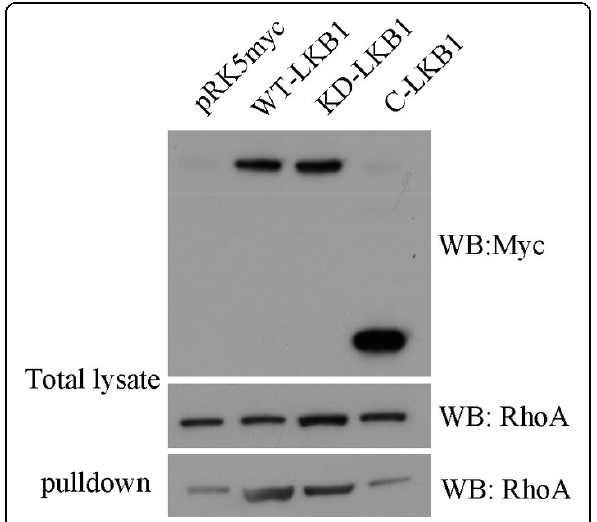
Figure 5 Expression of LKB1 activates RhoA in HeLa-S3 cells . Cells were transfected with different LKB1 constructs and 24 hours after transfection, serum-starved for 12 hours. Cells were harvested and activated Rho. GTP levels were determined using a standard pull down assay. Wild type LKB1 and kinase dead LKB1 (D194A) induce a 3-4 fold increase in the levels of active RhoA relative to mock-transfected cells, whereas expression of a C-terminal fragment of LKB1 has no